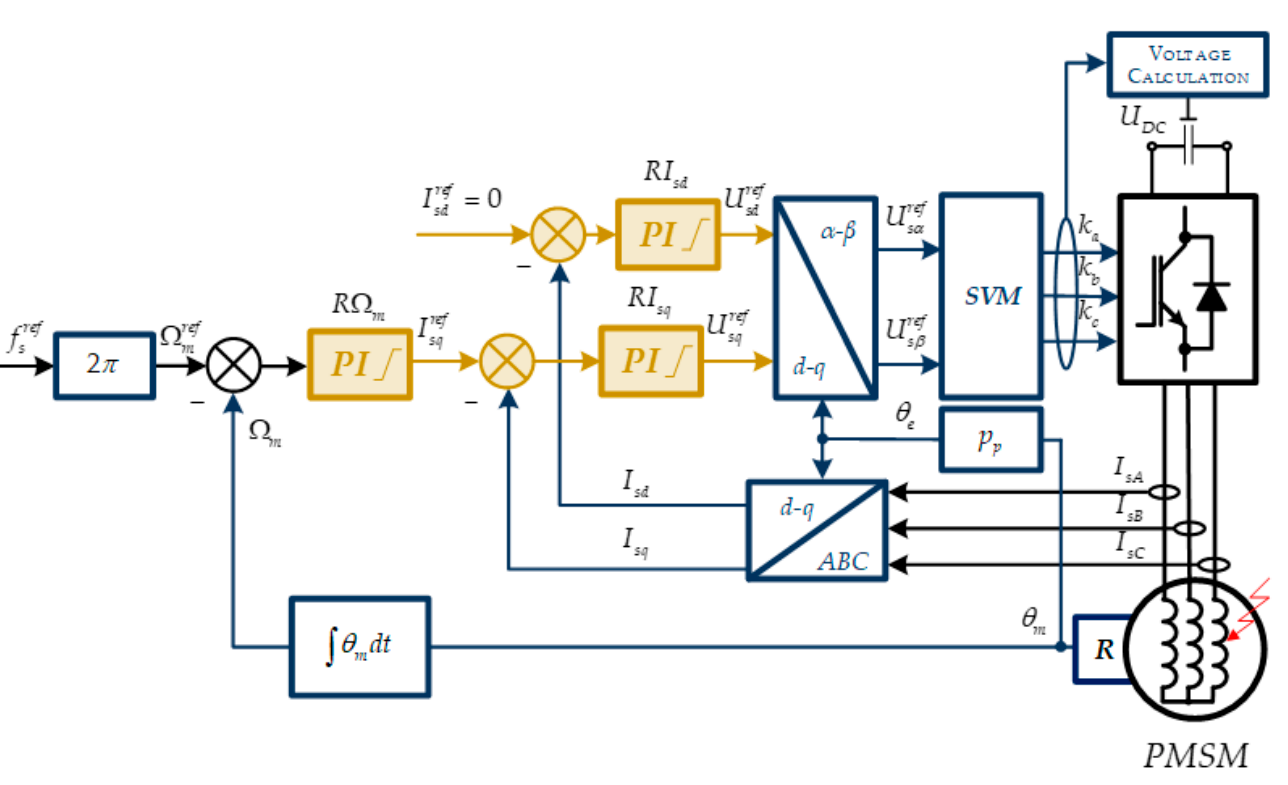
Figure 6. Scheme of the field-oriented control of the PMSM drive.